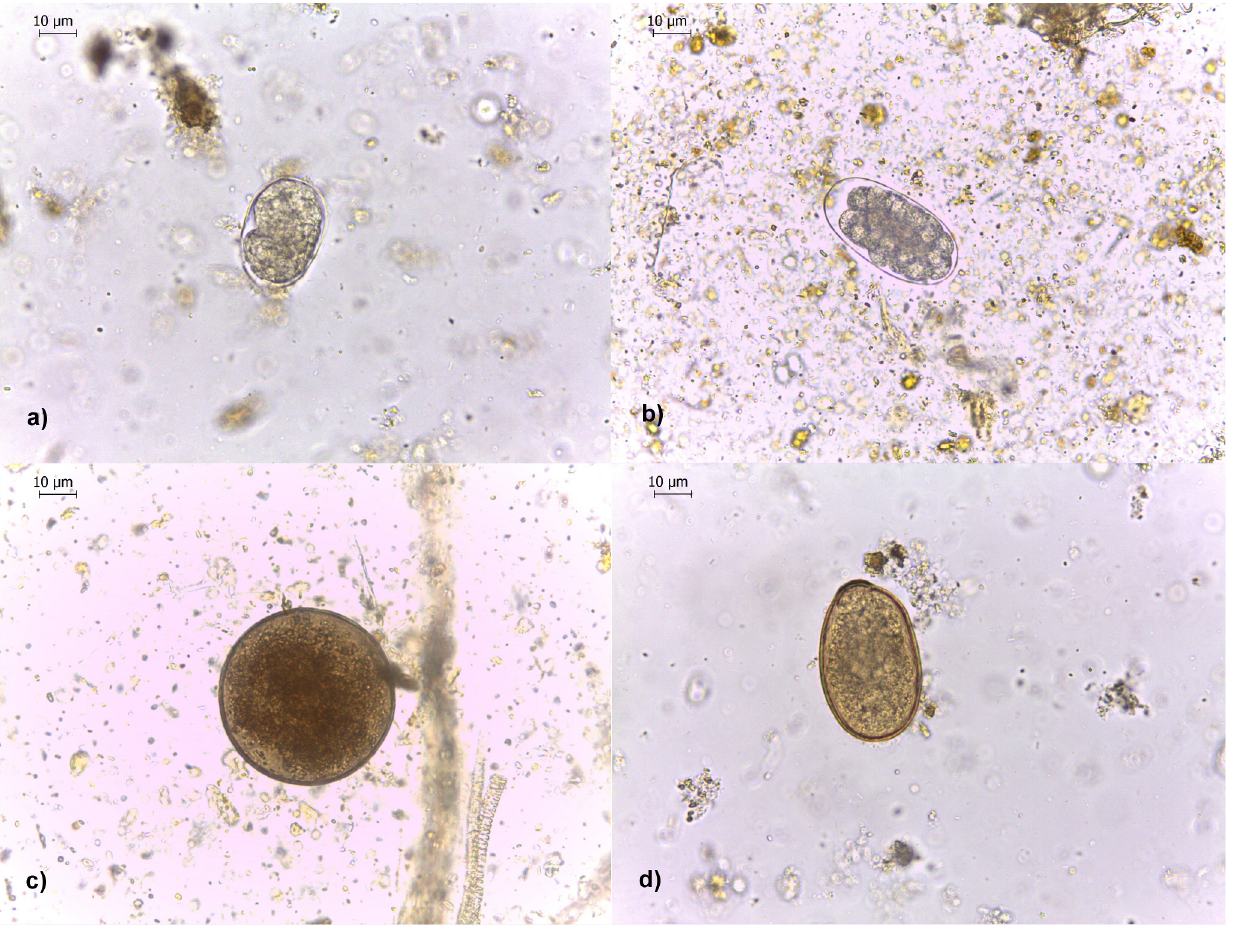
Fig 2. Photomicrographs of nematode eggs found in Galápagos giant tortoise faecal samples. (a) Small strongyle egg. (b) Large strongyle egg. (c) Ascarid egg. (d) Oxyurid egg. N.B. No trichurid eggs were found in samples returned to the laboratory for photography.